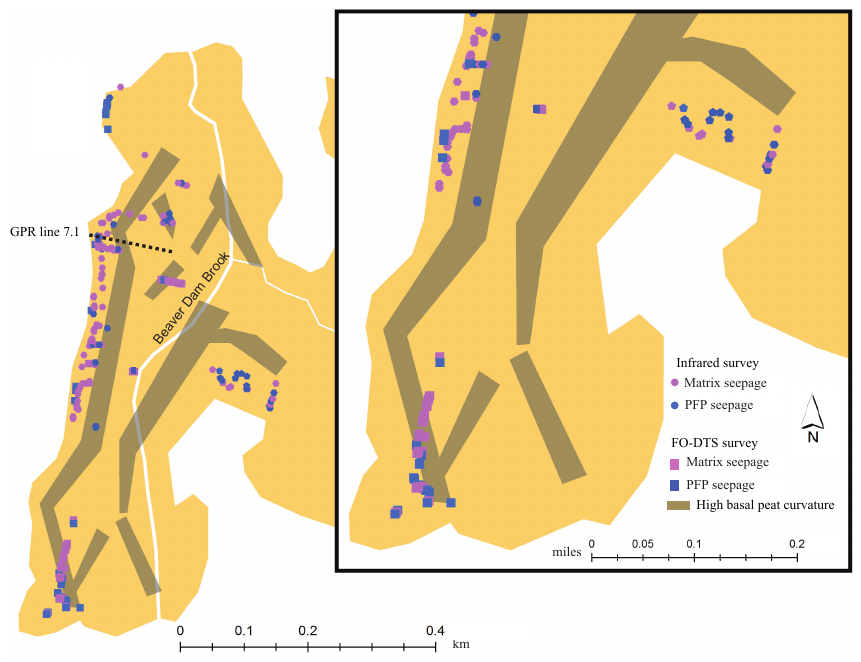
Figure 5. Map of seepage at Tidmarsh Farms determined with fiber-optic distributed temperature sensing (FO-DTS, squares) and thermal infrared (TIR) surveys (circles). Background shaded region(s) match the bounded area from Fig. 1b, and darker background shading delin- eates zones of high curvature (the 2nd derivative of the thickness) of the peat–sand interface (Fig. 2). For both methods, light purple to pink symbols indicate matrix (type 1) seepage, and dark blue indicates locations of PFP (type 2) seepage. From FO-DTS data, a location was tagged as seepage if the standard deviation was less than 1.5 and the temperature was less than 15 ◦ C for the matrix and less than or equal to 11 ◦ C for PFP seepage. From TIR surveys, seepage was distinguished by temperatures of 9–11 ◦ C for interior seepage, and 11–15 ◦ C for matrix seepage. The location of GPR line 7.1 is shown on this figure to reference data for the conceptual model in Fig. 9.